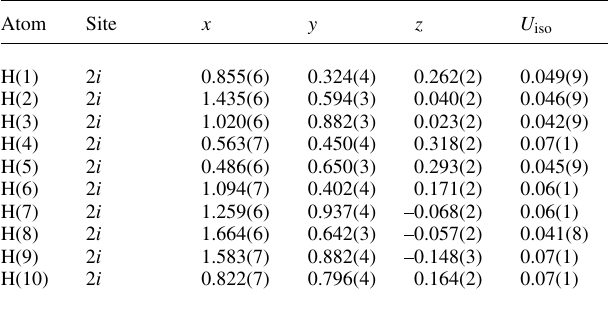
Table 2. Atomic coordinates and displacement parameters (in Å 2 )